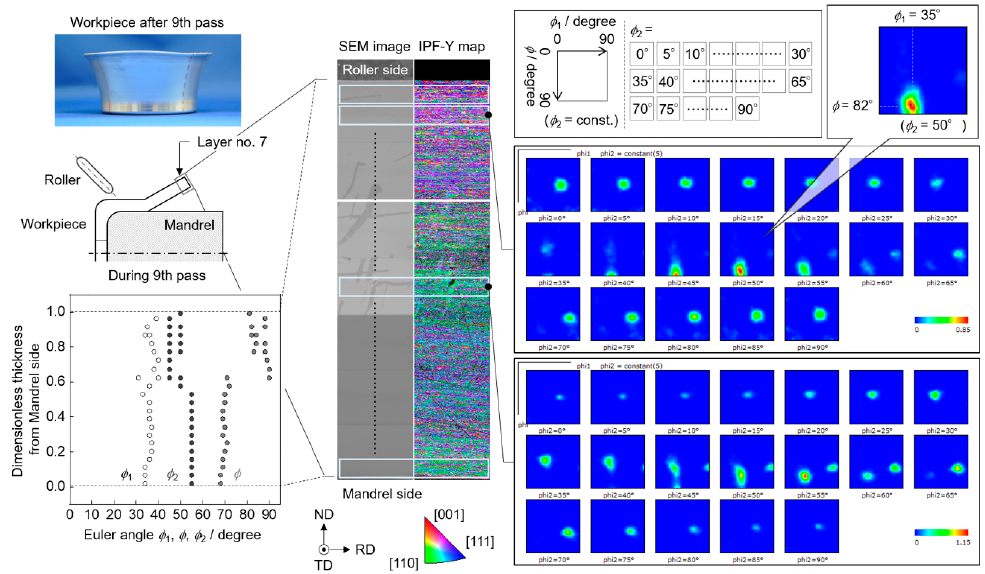
Figure 4. Photograph of the workpiece after the 9th pass, orientation distribution function (ODF) obtained at local areas for layer 7 on the 9th pass, and SEM images, IPF Y maps, and distribution of the Euler angle at a strong peak of the ODF in the thickness direction.